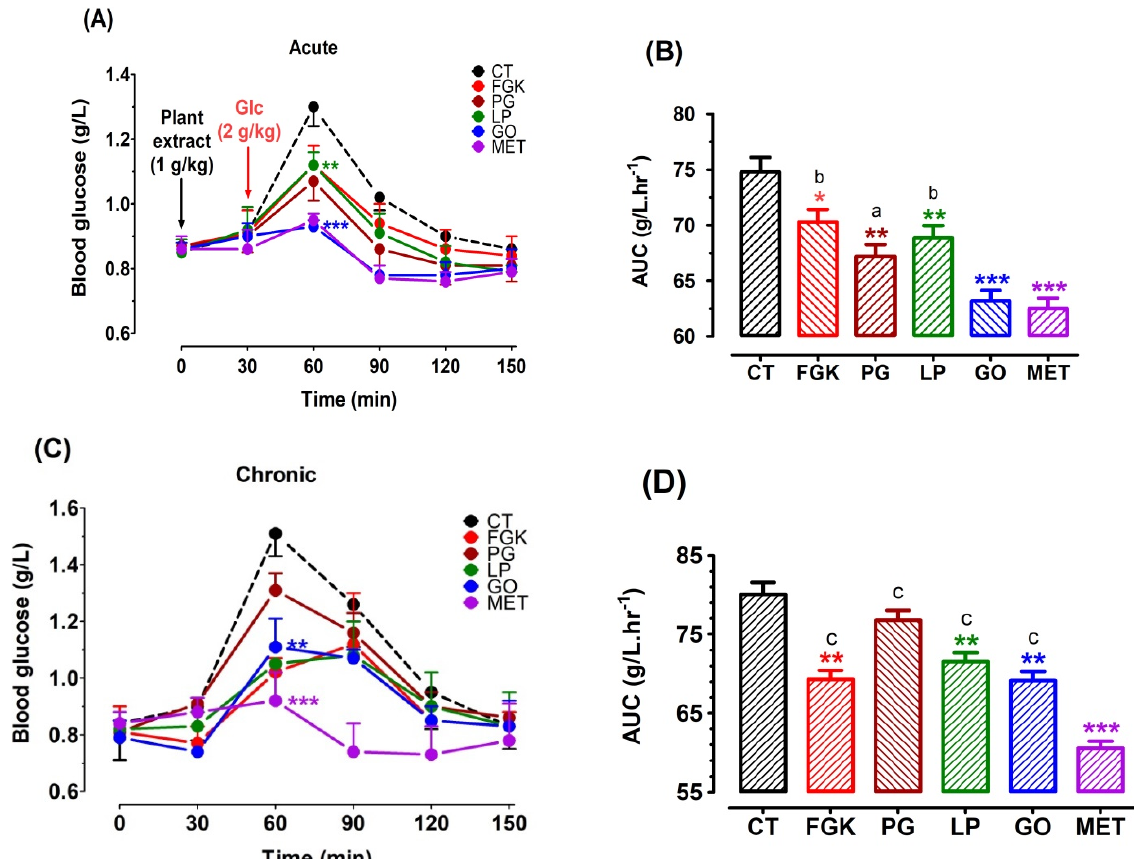
Figure 2. Acute and chronic OGTT after oral treatment of rats with plant extracts. Rats were force-fed intragastrically with distilled water as a negative control (CT, ■ ), 1 g/kg of the different aqueous plants extracts (LP, ■ ; PG, ■ ; FGK, ■ ; GO, ■ ), or 1 g/kg of the reference antidiabetic drug metformin (MET, ■ ) for 4 weeks. OGTT was performed on fasted rats every 30 min during 2 h after the first glucose (2 g/kg) overload (acute, panel ( A )) and at the end of the 4-week treatment (chronic, panel ( C )). Panels ( B ) and ( D ) show the AUCs (CT, ■ ; LP, ■ ; PG, ■ ; FGK, ■ ; GO, ■ ; MET, ■ ) for panels ( A ) and ( C ) respectively and were calculated using GraphPad Prism Version 8.0 software. * p < 0.05; ** p < 0.01; *** p < 0.001 in comparison with the control (Dunnett’s test). ( a ) p < 0.05; ( b ) p < 0.01; ( c ) p < 0.001 in comparison with MET (Newman-Keuls test).